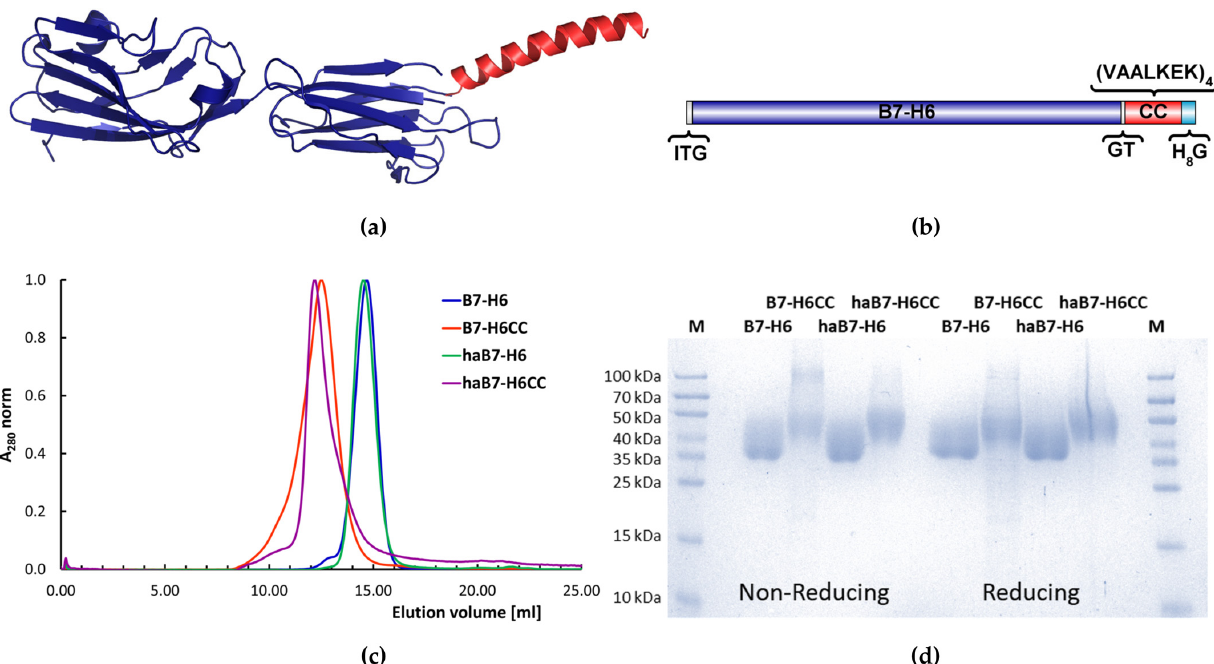
Figure 1. Molecular design and recombinant expression of B7-H6CC. ( a ) A model of B7-H6CC based on the crystal structure of B7-H6:NKp30 complex (PDB 6YJP, [37]); ( b ) schematical representation of B7-H6CC amino acid sequence highlighting the coiled coil motif; ( c ) Comparison of normalized (ha)B7-H6 and (ha)B7-H6CC SEC elution profiles; ( d ) SDS-PAGE electrophoresis as quality control of the expressed proteins, M refers to molecular weight